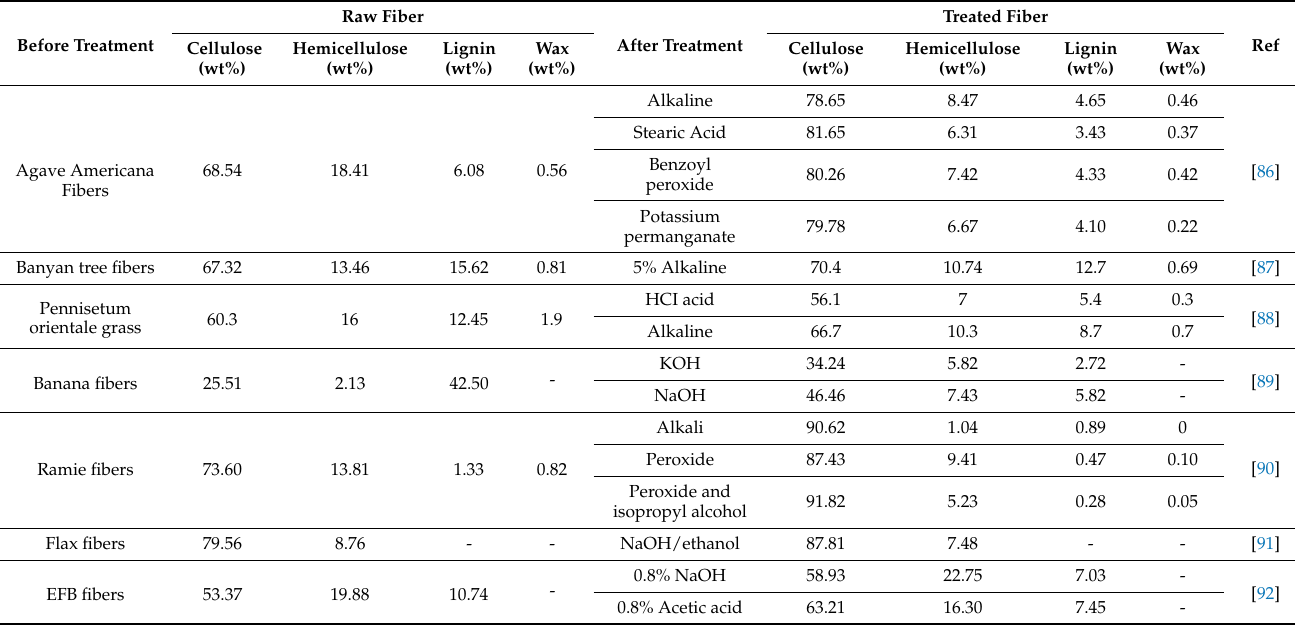
Table 3. Chemical composition of raw and treated fiber in previous studies.